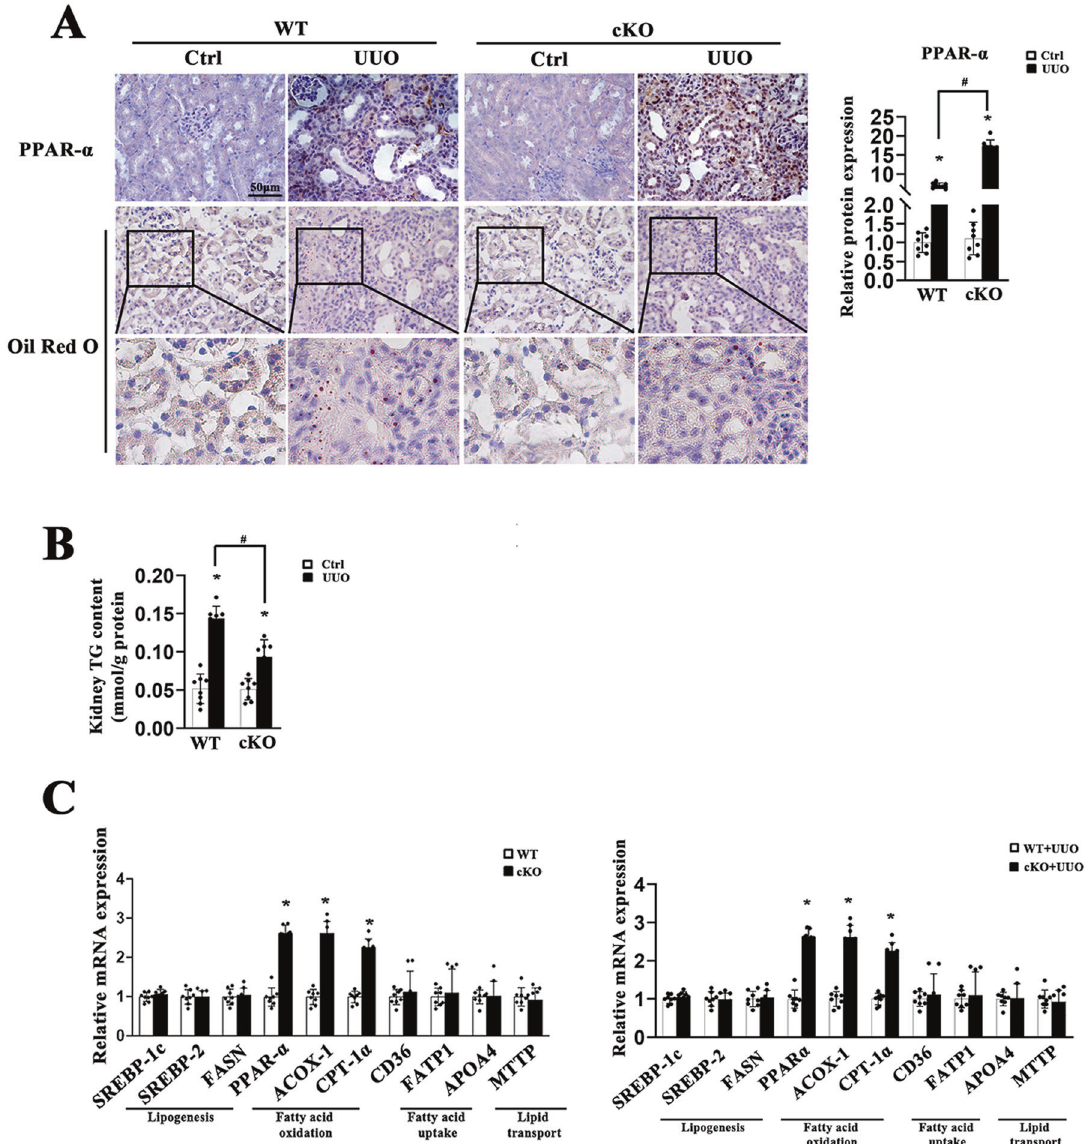
Fig. 3 STAT6 de fi ciency in tubular cells attenuates UUO-caused lipid accumulation. The tubular-speci fi c-Stat6 KO and control littermates were sacri fi ced 1w after UUO operation. A Representative IHC staining of PPAR α and Oil Red O staining from Stat6 WT and cKO kidneys with or without UUO, and quanti fi cation for PPAR α was performed. B TG content were determined in the kidneys from Stat6 WT and cKO mice with or without UUO. C mRNA levels of genes related to lipid metabolism in Stat6 WT and cKO mice with or without UUO operation. Results are expressed as the mean ± SD ( n = 8, * p < 0.05, Stat6 WT vs . Stat6